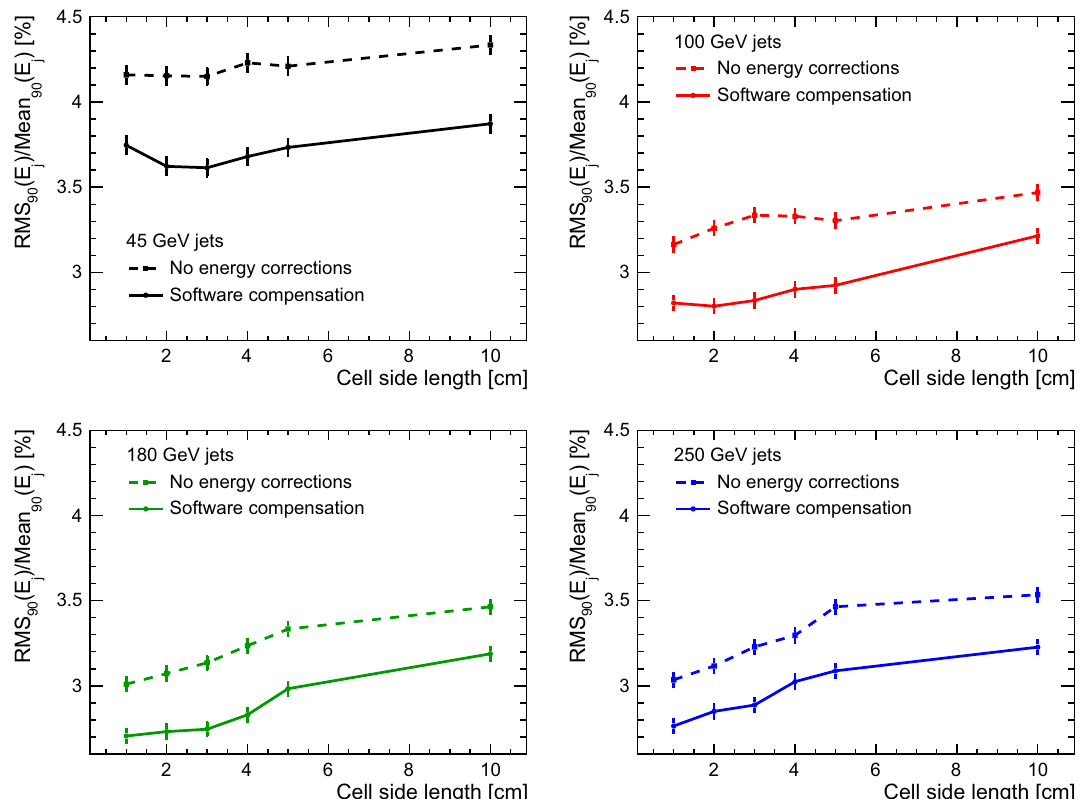
Fig. 11 Jet energy resolution as a function of the HCAL cell size for different jet energies. The dashed lines show the jet energy resolution without energy correction. The solid lines show the jet energy resolution obtained when applying SC at the reclustering step